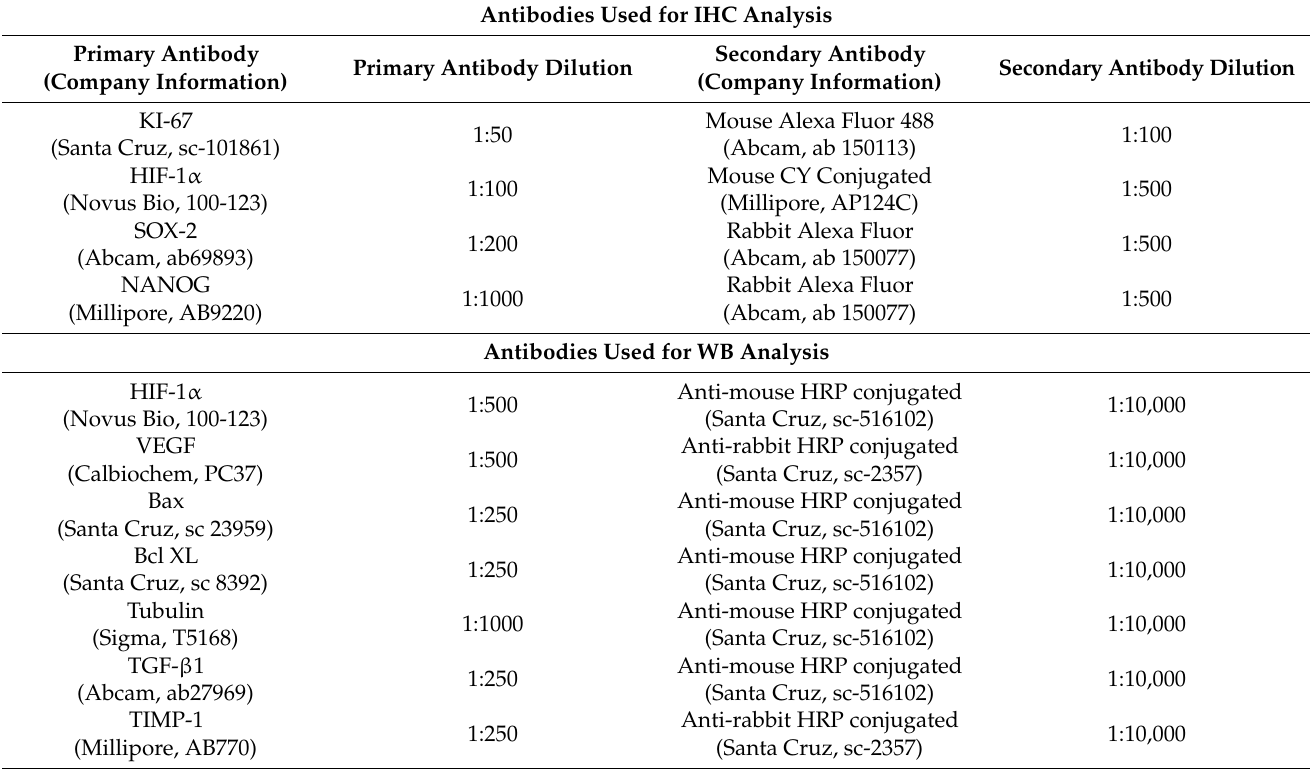
Table 2. Details of primary and secondary antibodies